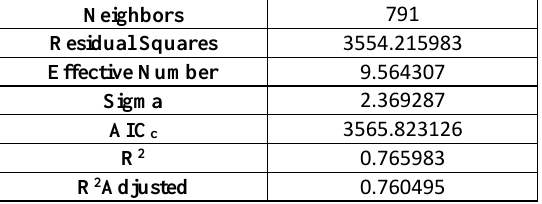
Table 2. Summary results of